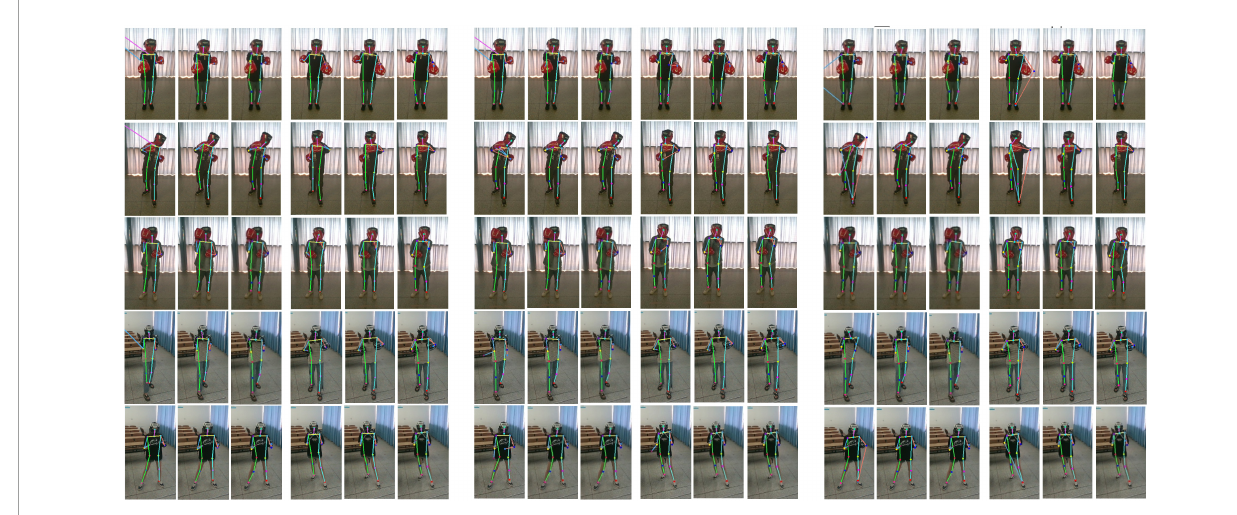
FIGURE10 The pose estimation of the OP network (left) , HG network (middle) , and HR network (right) after model transfer.